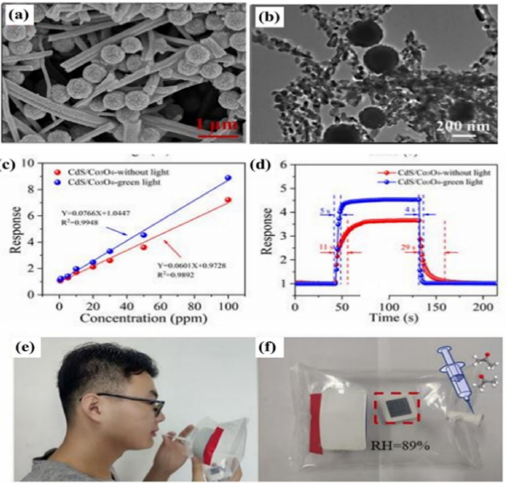
Figure 3. SEM and TEM images of ( a , b ) CdS/Co 3 O 4 nanocomposite. ( c ) Curve fitting, ( d ) with and without the illumination of green light, response/recovery time of the CdS/Co 3 O 4 ‐ based acetone sensor. The breath gas investigation of the Co 3 O 4 /CdS sensor. ( e ) Healthy experimenter breath sample is collected with air bag. ( f ) Injection of 2 ppm of acetone in to healthy people’s exhaled breath Reprinted with permission from [75] Copyright 2022 Elsevier.